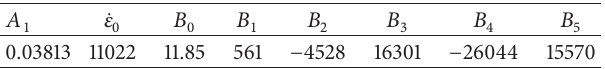
Table 3: Parameters in the dynamic constitutive equation of the foam silicone rubber [23].